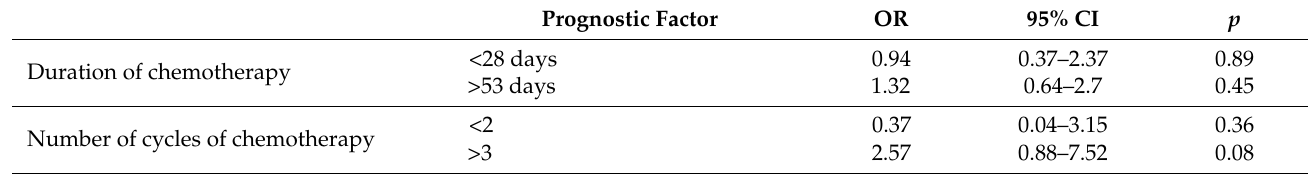
Table 4. Characteristics of sequential chemotherapy and radiotherapy in relation to KPS worsening. The values of the lower and upper quartiles were used as prognostic